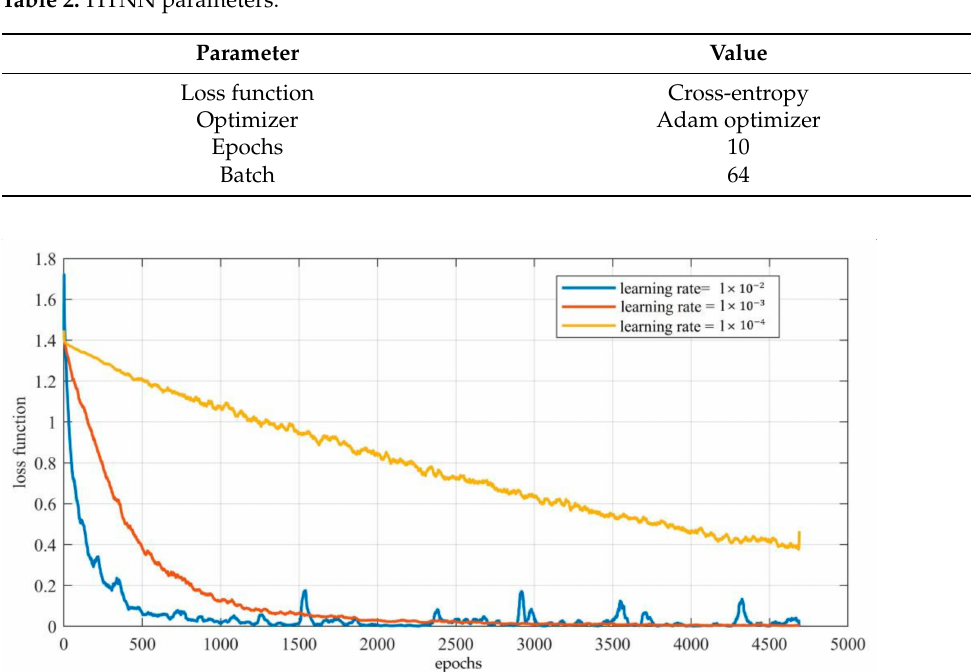
Table 2. HTNN parameters.